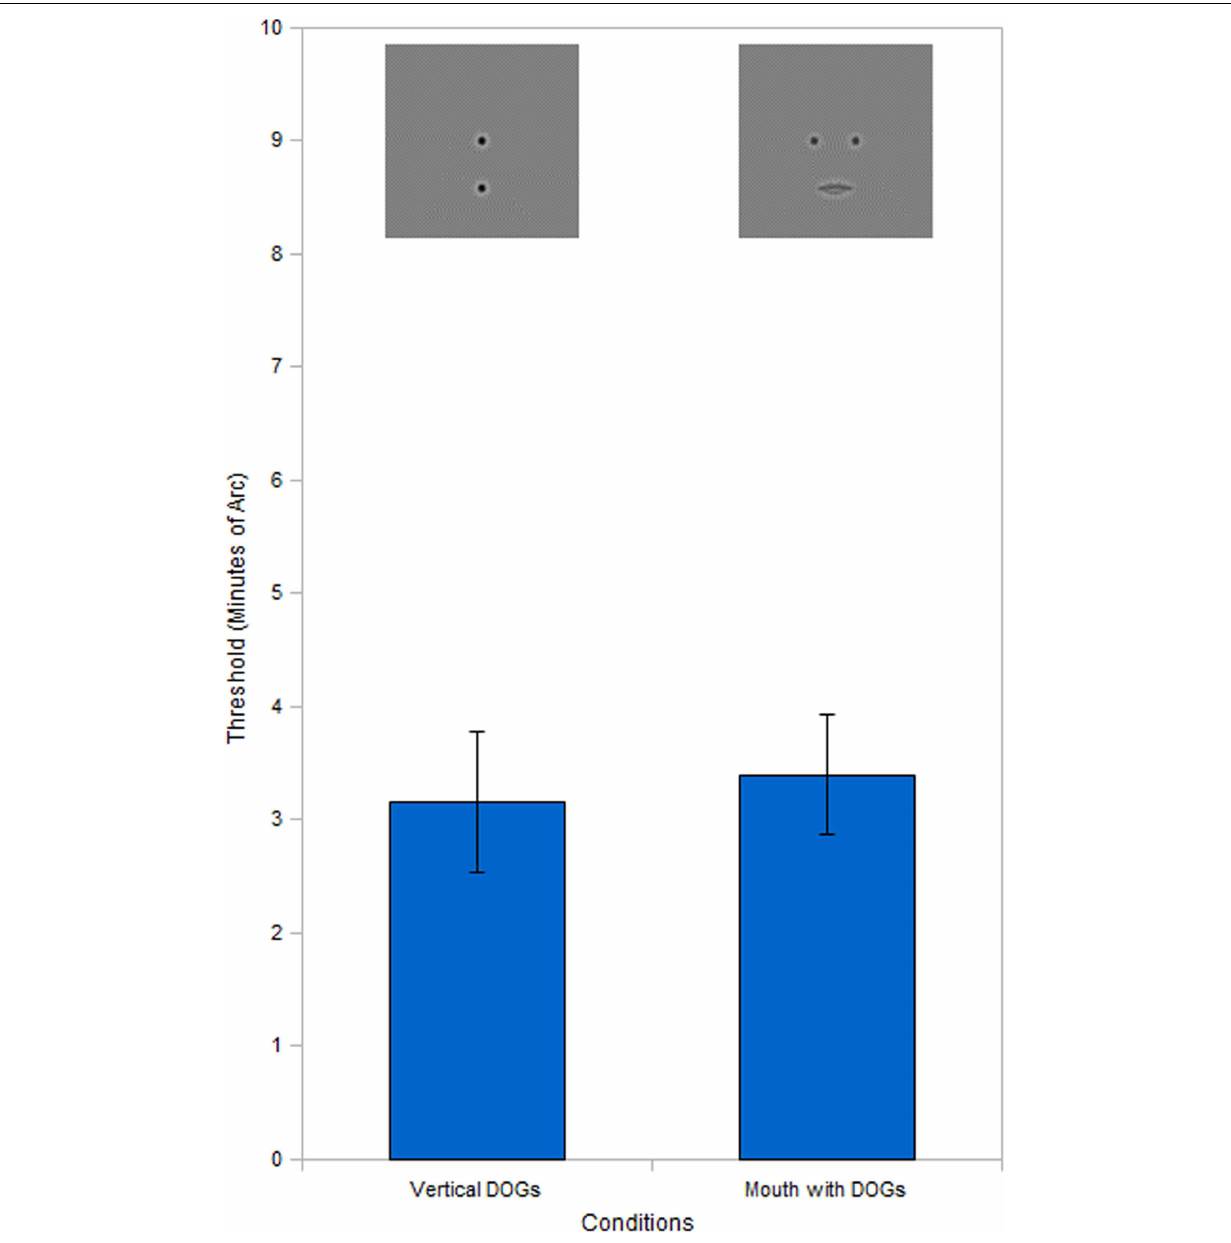
that our thresholds for isolated DOGs also fit well within the 95% confidence interval of the extrapolated function ( Figure 5 ). The thresholds from the full face with DOGs condition showed a sim- ilarly good fit when plotted as a function of the distance from each DOG to the nearest in-line reference point (side of the